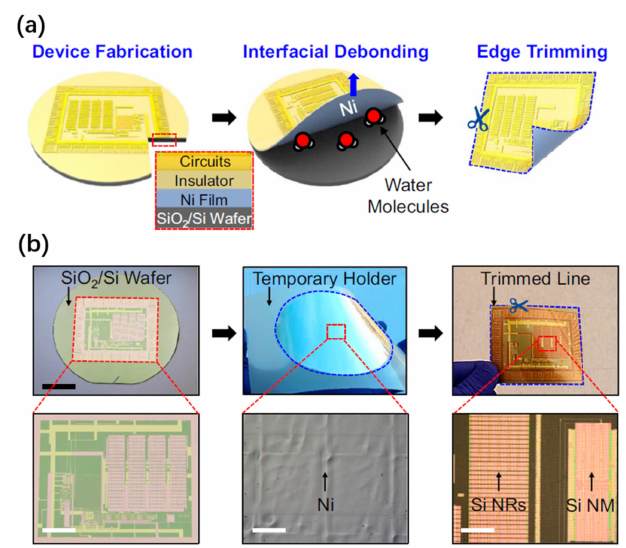
Figure 13. ( a ) Schematic illustrations of key steps for physically liberating thin-film nanoelectronics from a fabrication SiO2/Si wafer in water. ( b ) Optical images of the thin-film nanoelectronics on the SiO2/Si wafer (left), and peeled with a thermally releasable tape (middle), and then trimmed neatly (right). The bottom frame shows the corresponding microscope images. Si NRs in ( b ) stands for Si nanoribbons, and Si NM in ( b ) refers to Si nanomembrane. Adapted from